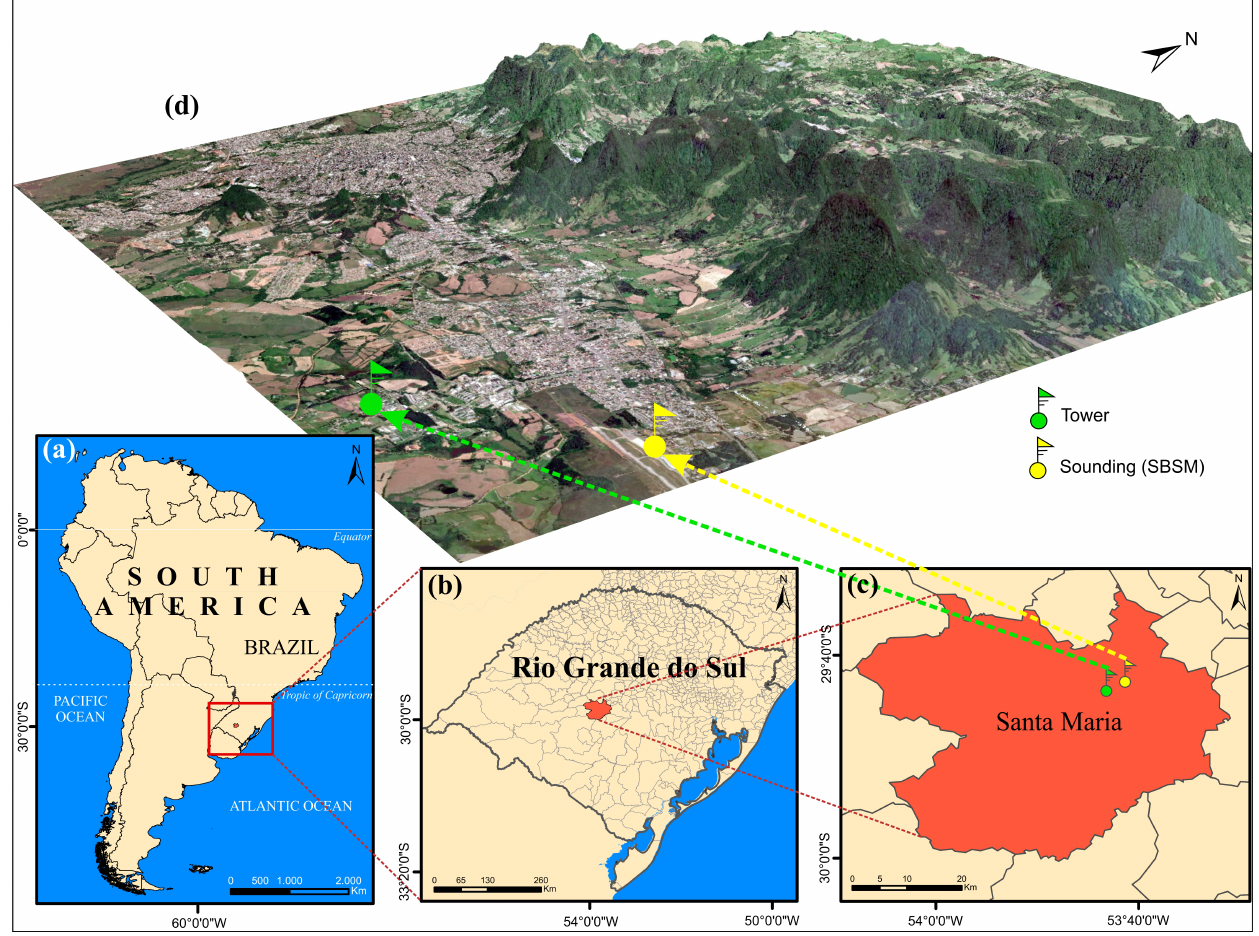
Figure 1. ( a ) Location of the state of RS in relation to South America; ( b ) position of the city of SM in RS; ( c ) location of the tower (green) and sounding on the SBSM (yellow) in relation to SM; ( d ) local topography to the north of